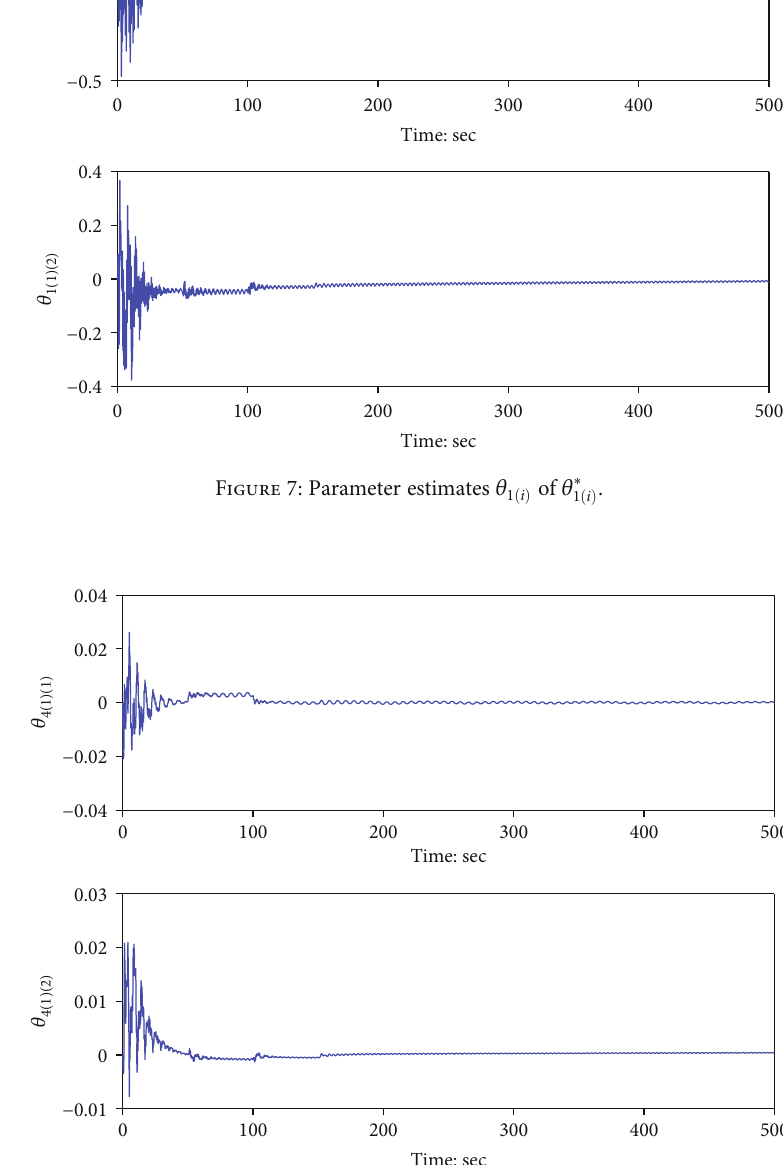
Figure 8: Parameter estimates θ